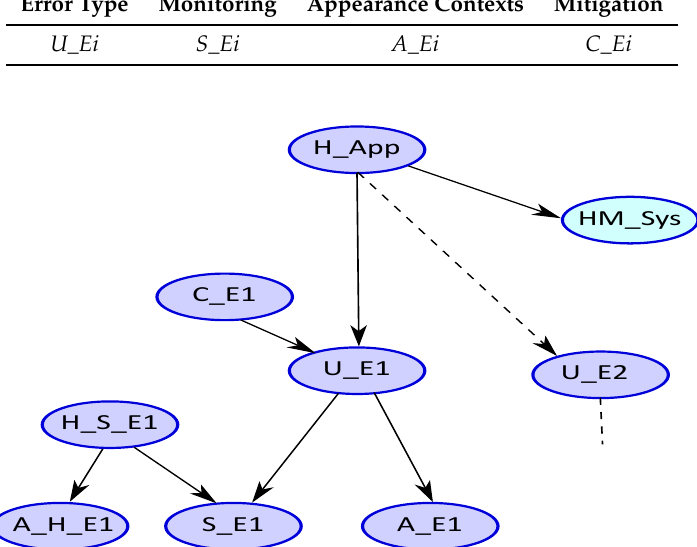
Figure 9. BN structure associated to FMEA _ MIT pattern where C_Ei represents the error mitigation.